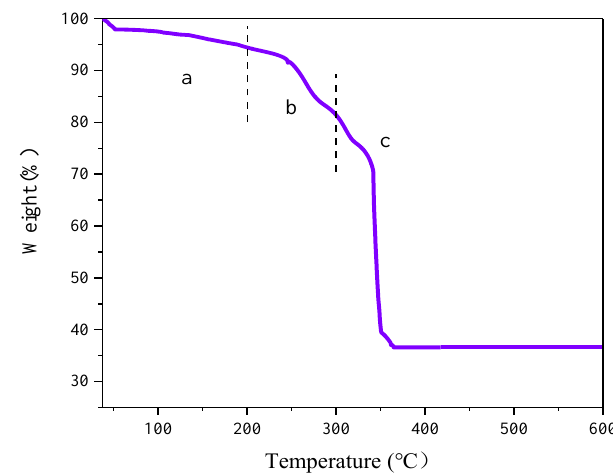
Figure 1. Thermogravimetric analysis under air (5 °C/min heated rate) of